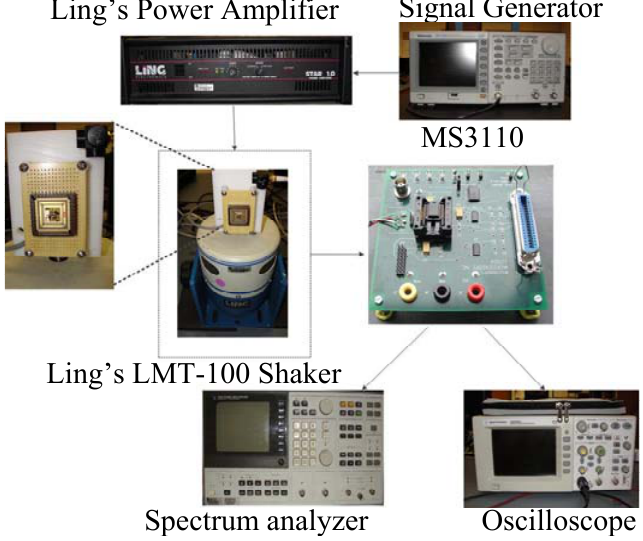
Figure 9. Test setup with inset showing the PCB where the DUT and reference accelerometer are